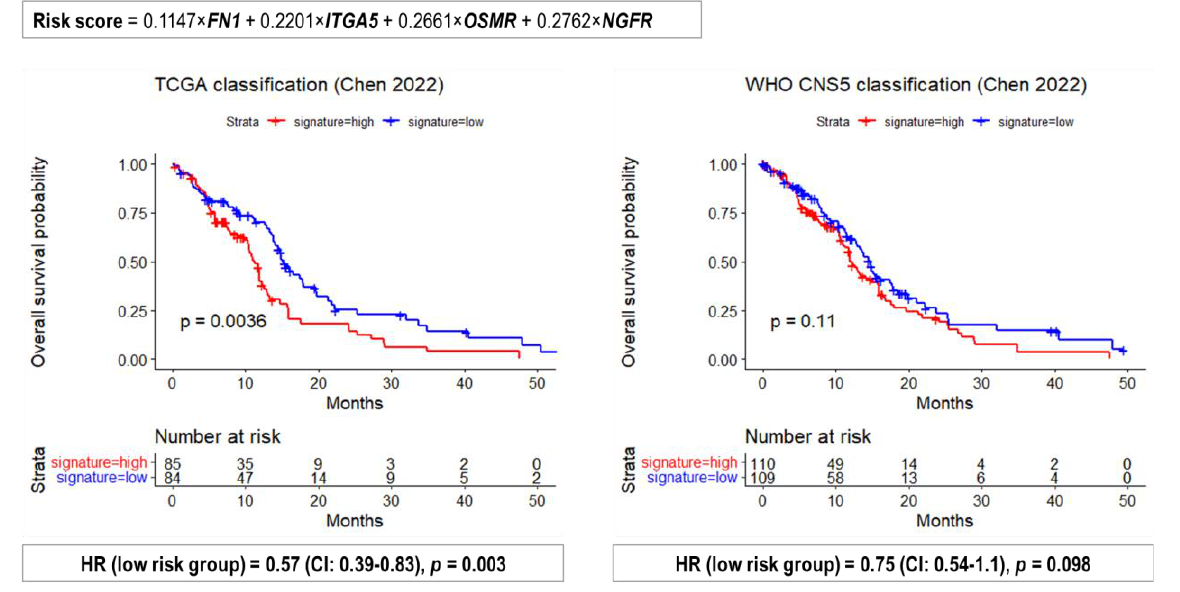
Figure 11. Performance of the 4-gene signature [35] to predict the survival of patients with glioblas- toma according to the basic TCGA ( left panel ) and the WHO CNS5 ( right panel ) classifications.